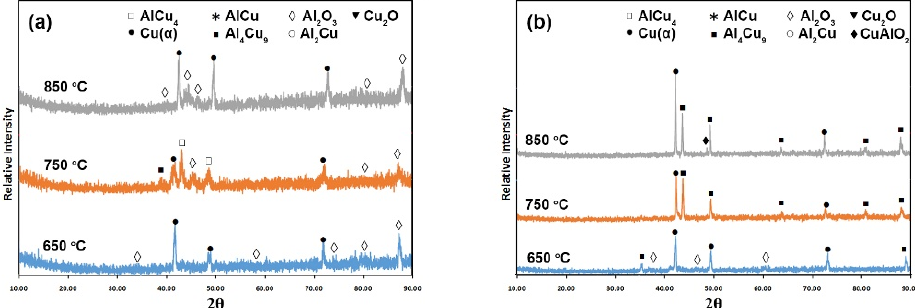
Figure 8. XRD pattern of sintered samples ( a ) C2 and ( b ) C3 at different temperatures. The green density of cold-pressed samples and sintered ones are gathered in Figure 9. Unmilled powders demonstrated considerably higher green density because of the spherical shape of enclosing powders. Green density decreased with milling up to 90 min.